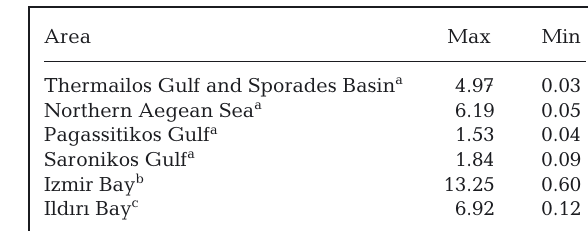
Table 4. Maximum and minimum total suspended matter (TSM) concentrations from bays of the Aegean Sea